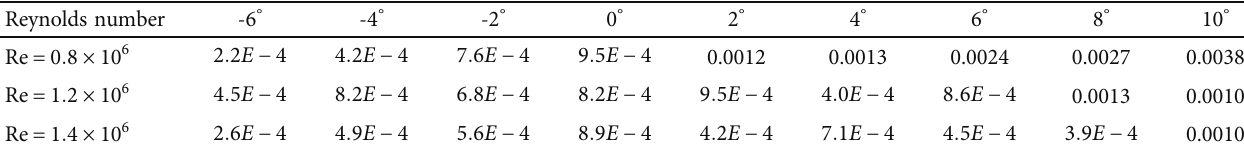
Table 3: Δ Cl for DBLN-526 airfoil.